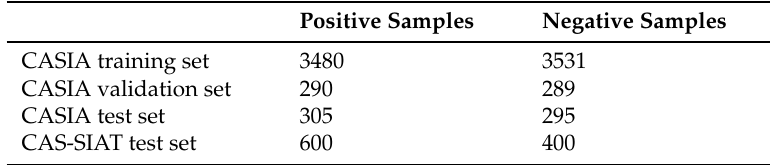
Table 2. Data distribution in a non-person-disjoint manner for the network trained with CASIA-Iris-Interval dataset and tested with both datasets.